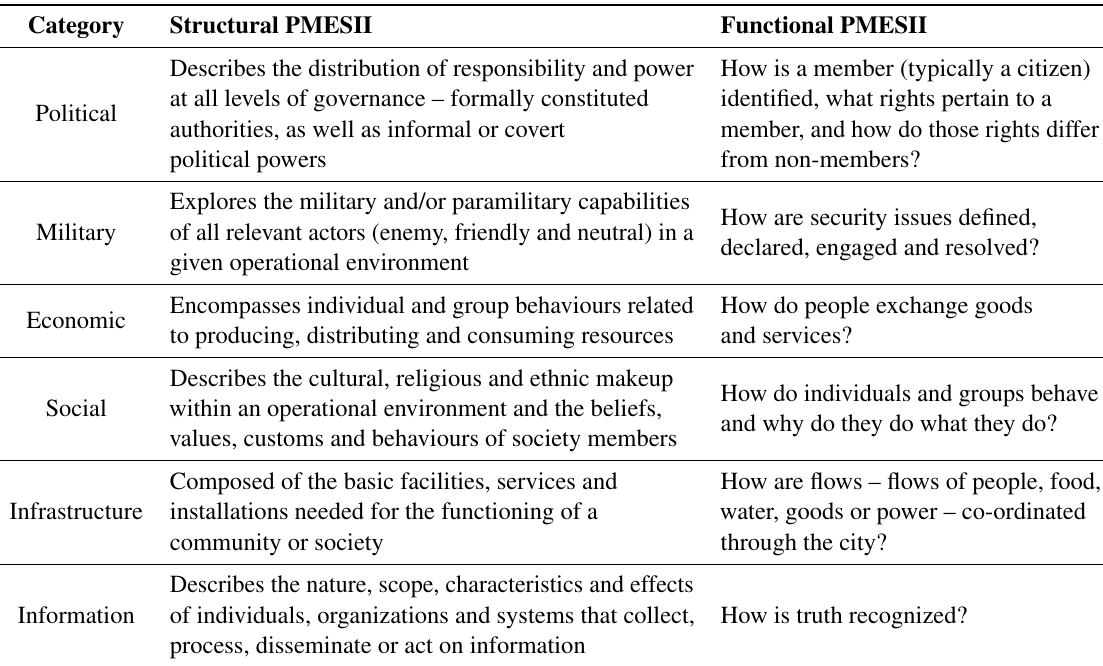
Translation of functional PMESII categories to functional